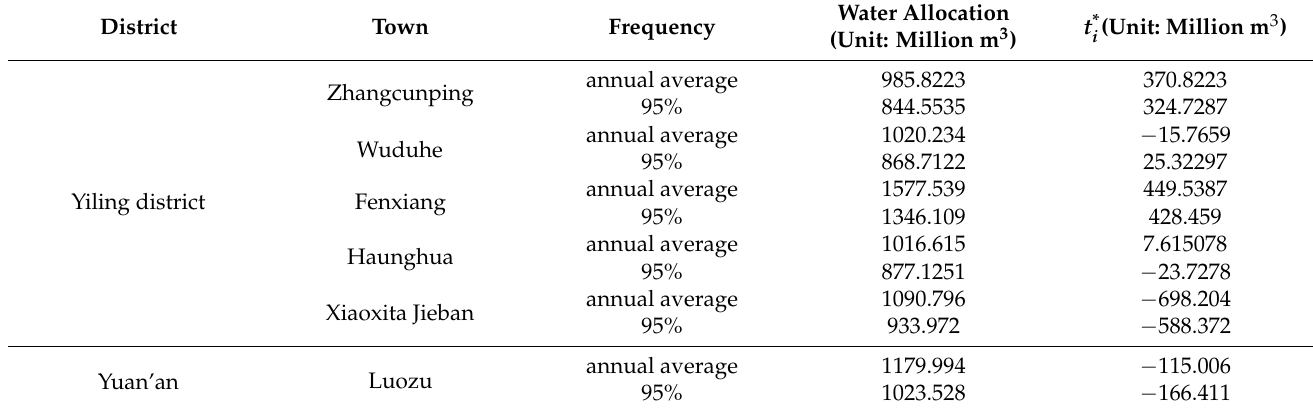
with symmetric information. i